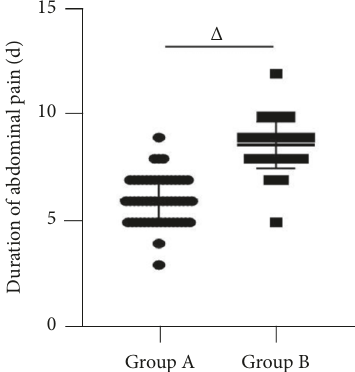
Figure 4: Menstrual flow score. Note . Δ indicates P < 0 . 05 for the difference between groups A and B.